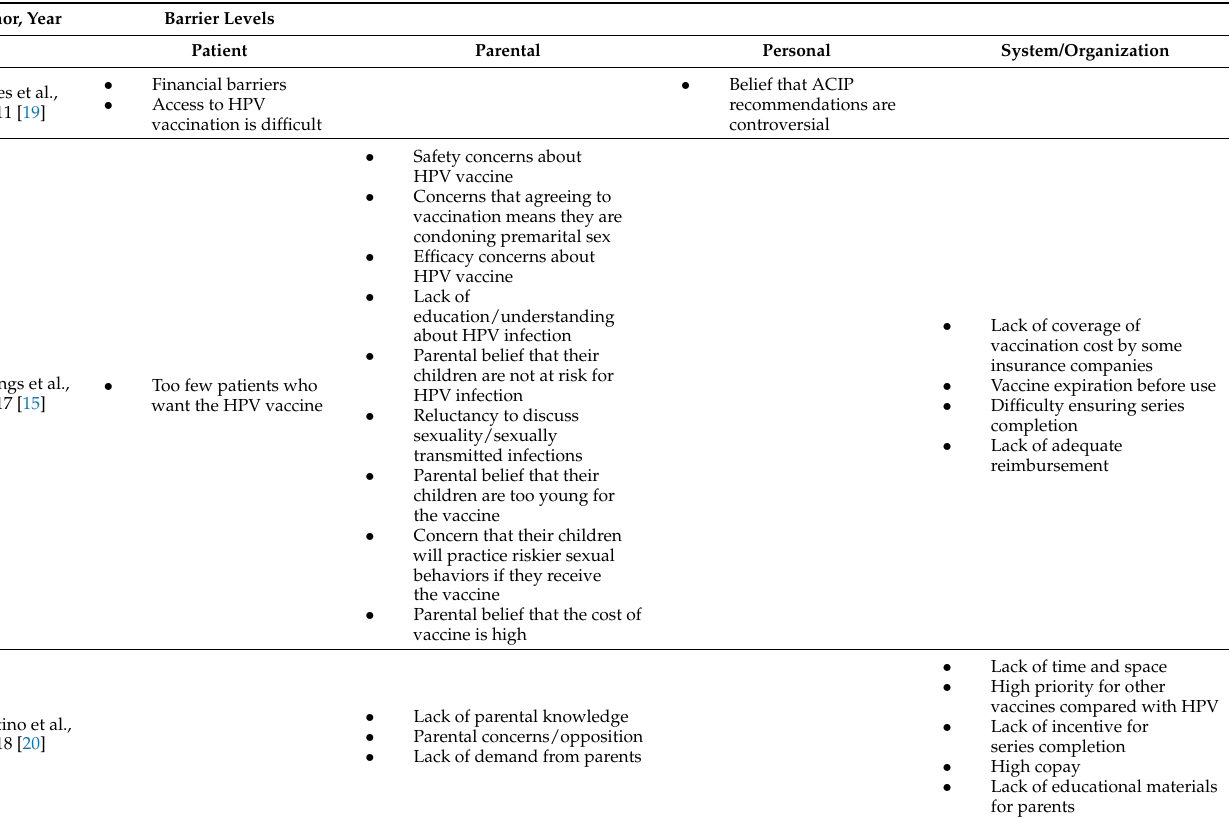
Table 4. Summary of key barriers grouped by level of